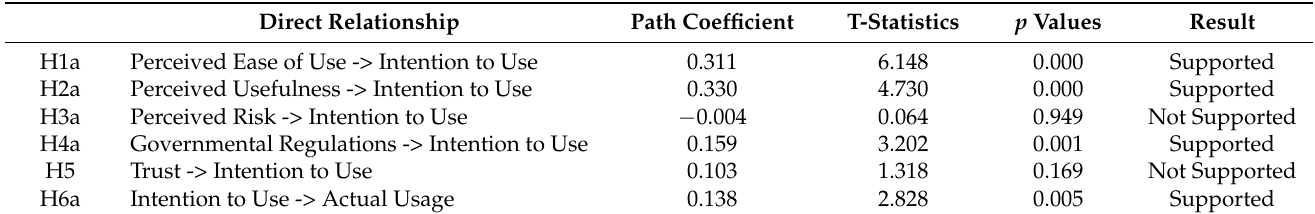
Table 5. Structural Model Analysis Results and Hypotheses Testing.